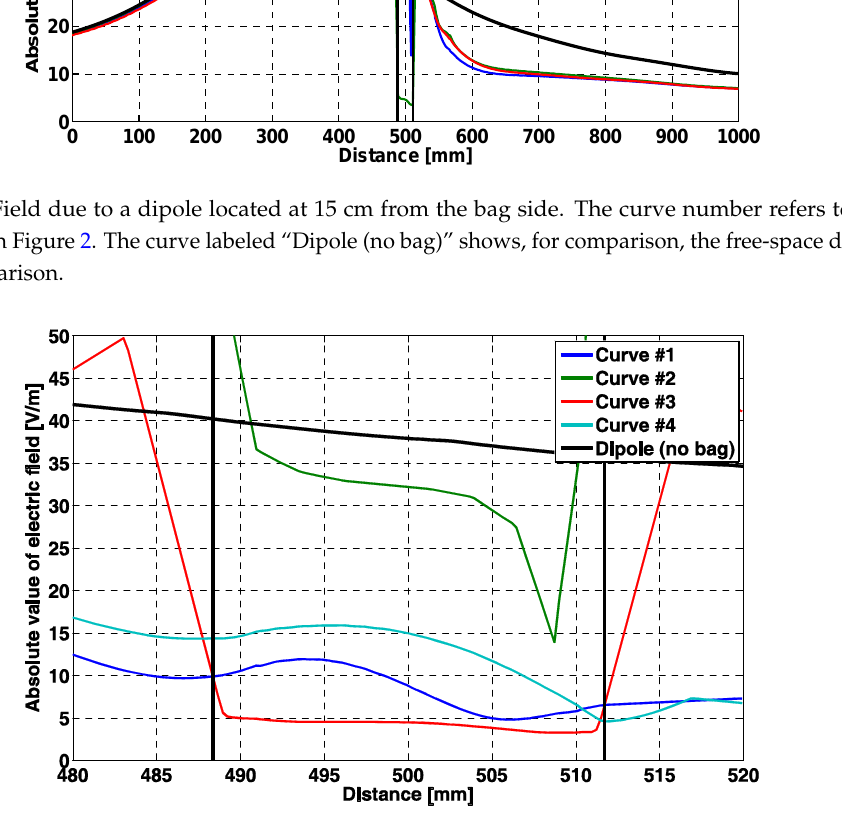
Figure 8. Expanded view of the field inside the bag, due to a dipole located at 15 cm from the bag side. The curve number refers to the segments in Figure 2. The curve labeled “Dipole (no bag)” shows, for comparison, the free ‐ space dipole field comparison.